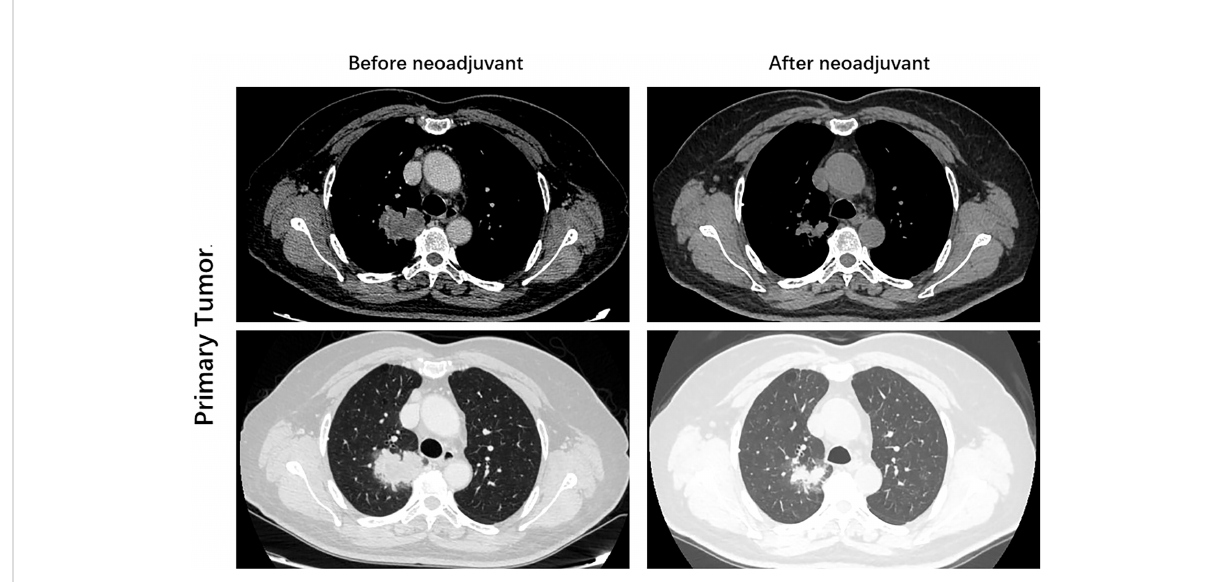
FIGURE 1 Images during neoadjuvant savolitinib treatment. Enhanced chest CT images of right lung adenocarcinoma before and after the neoadjuvant